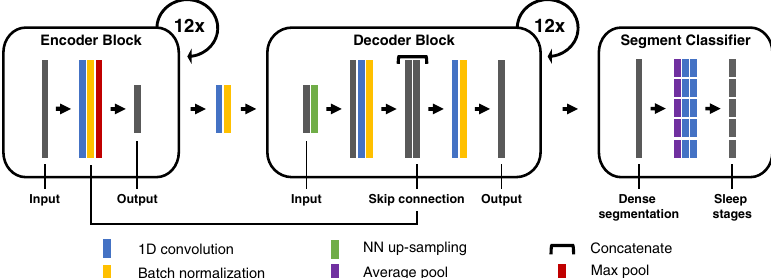
Fig. 2 Model architecture. U-Sleep is a special fully convolutional neural network architecture designed for physiological time-series segmentation tasks such as sleep staging. It consists of an encoder (left) which encodes the input signals into dense feature representations, a decoder (middle) which projects the learned features into the input space to generate a dense sleep stage representation as shown in Fig. 1, and fi nally a specially designed segment classi fi er (right) which generates sleep stages at a chosen temporal resolution. Please see the Method section and Supplementary Table 2 for details on the U-Sleep model